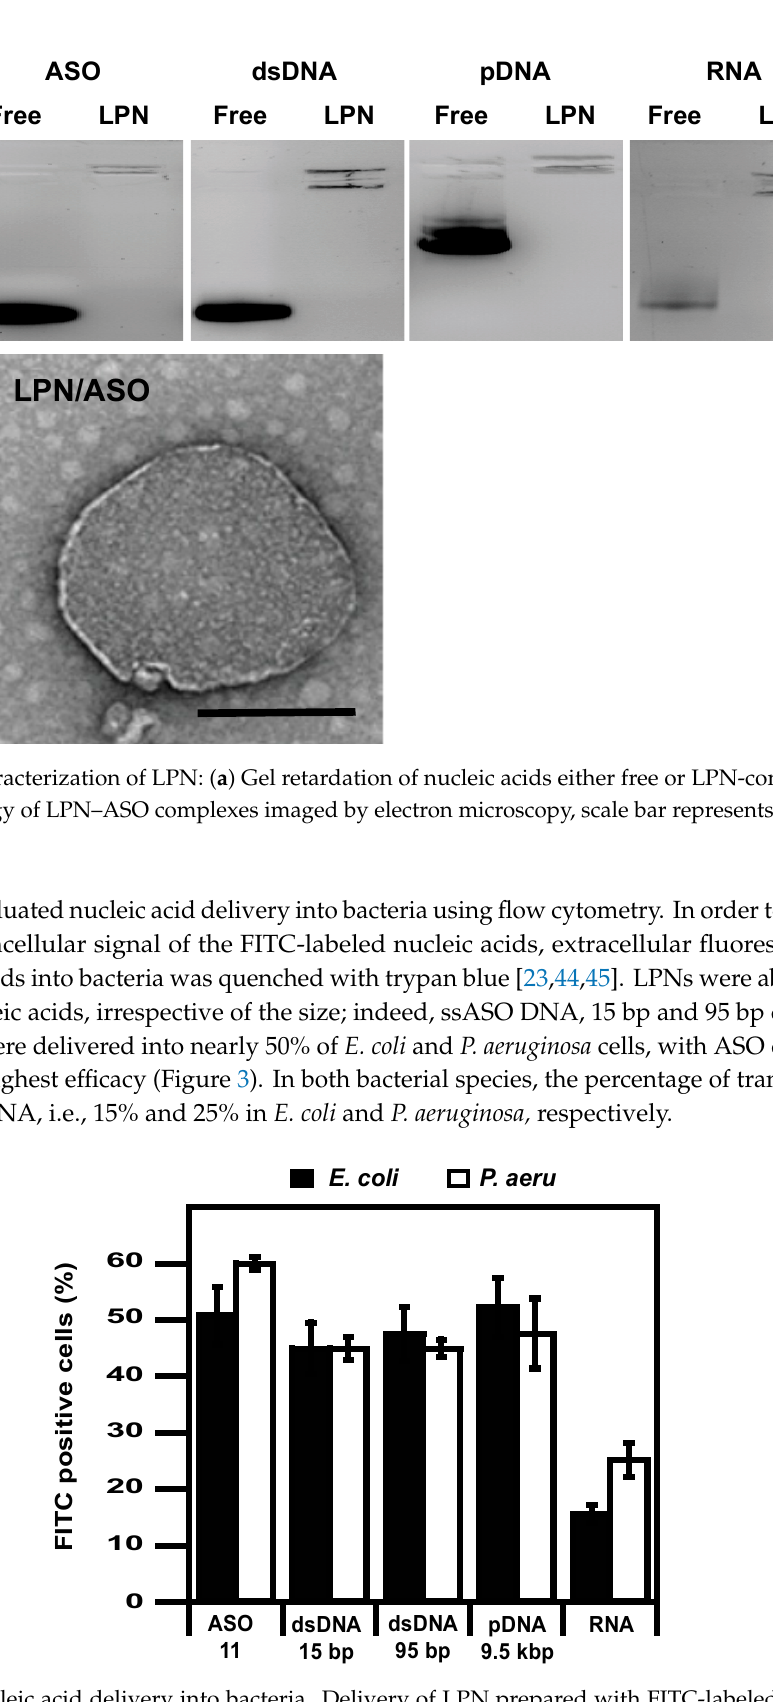
Figure 3. Nucleic acid delivery into bacteria. Delivery of LPN prepared with FITC-labeled nucleic acids was evaluated by flow cytometry after 2 h incubation at 37 ° C with bacteria.